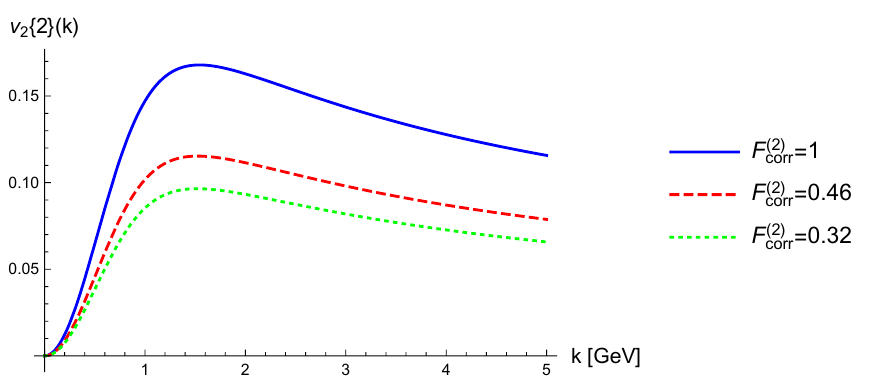
Figure 6 . The 2nd order cumulant as in (cid:12)gure 5 for B = 2 = GeV 2 but now compared to values of the color correction factor F (2) corr = 0.45 (0.32) that correspond to an average of m = 3 (5) emitted particles per source.